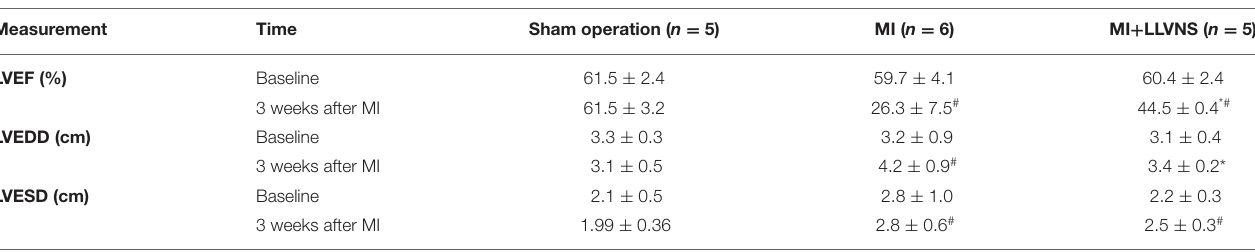
TABLE 2 | Echocardiographic measurements between the 3 groups.